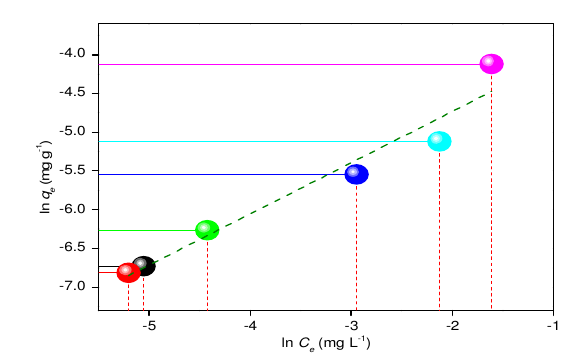
Fig. 10: Freundlich Isotherm Indicating the plot of LN (CE) against LN (QE) (Adsorbent Dose 0.5 g Per 50 ml, pH 6, Shaking Time 2h, Temp: 25 ± 2 O C, at various initial As (III) Concentrations with Shikarap Iron Ore) The D-R model is described in Equation (5).